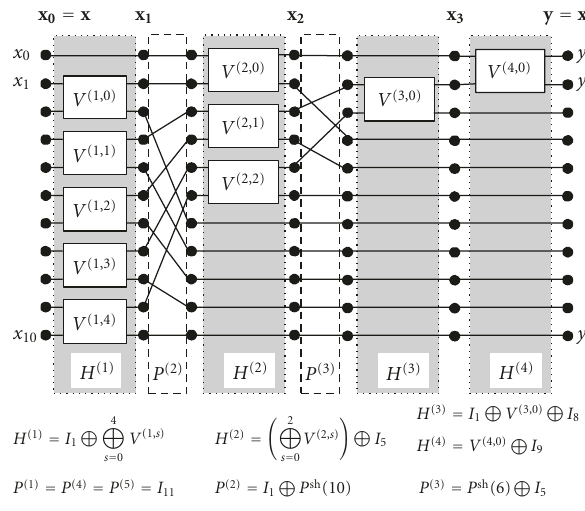
Figure 2: The fast Hadamard-like transform of order N = 11. Figure 3: The fast Haar-like transform of order N = 11.